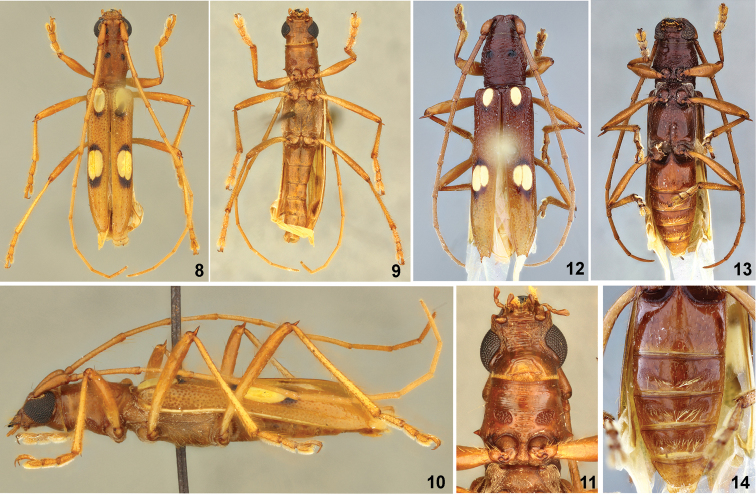
8–11Berabaangeli sp. nov., holotype, male: 8 dorsal view 9 ventral view 10 lateral view 11 detail of prosternum. 12–14Berabamarica Martins & Galileo, 1999: 12 dorsal view 13 ventral view 14 detail of ventrites.